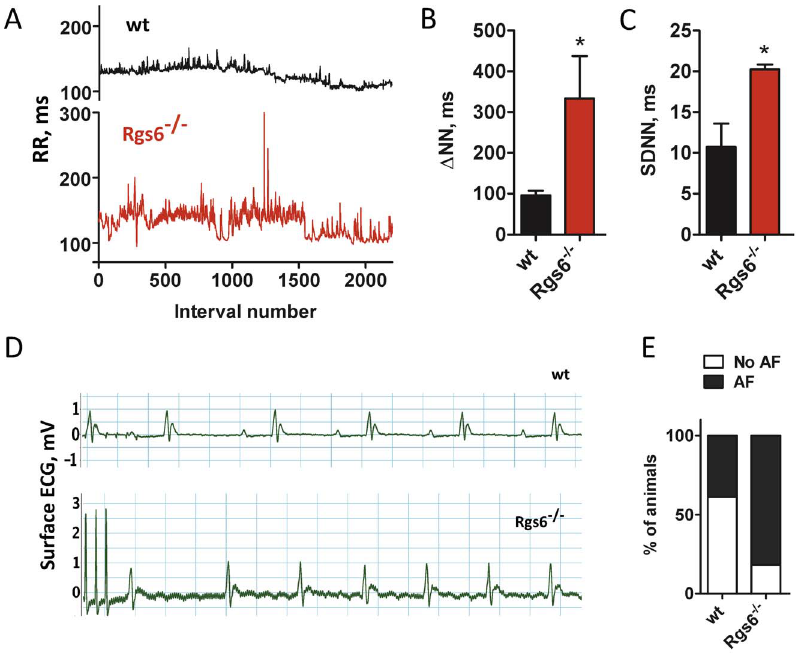
Figure 4. Inactivation of Rgs6 disrupts cardiac rhythm in mice. A, Representative tachograms of RR intervals from wild-type (black) and Rgs6 2 / 2 (red) mice recorded by ECG radiotelemetry. B and C, Summary of HRV analysis in conscious, freely-moving mice. D, Burst pacing induced AF in Rgs6 2 / 2 but not in wild-type mice. Note an irregular rhythm with no discernible P waves in the Rgs6 2 / 2 recording. E, Quantification of AF induction probability. Symbols: *, P ,